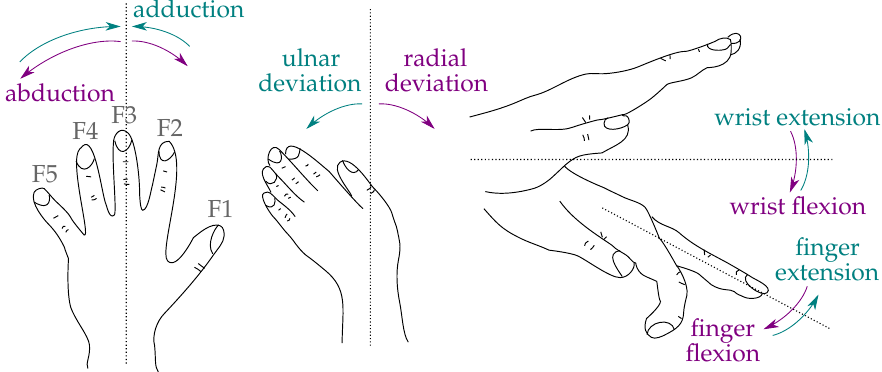
Figure 4. Definition of hand and finger movements, illustrated for the left hand. Ulnar and radial deviation are also known as ulnar/radial abduction or wrist adduction. Finger abduction in the MCP joints describes the movement away from the center of the extremity, whereas finger adduction refers to the movement towards the center of the